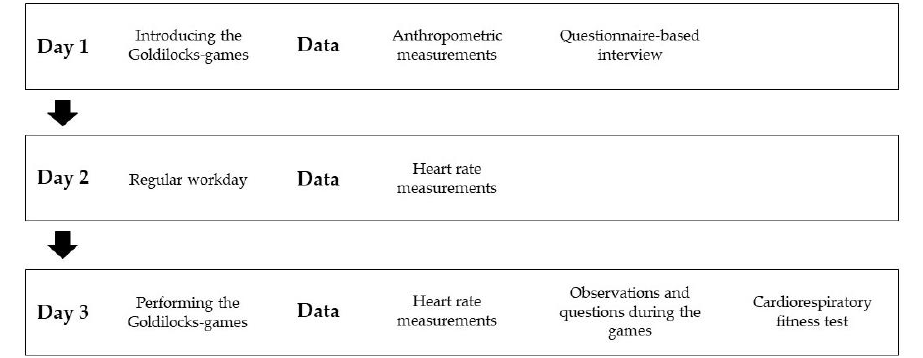
Figure 2. Study design for evaluating time with HIPA during a regular workday and the Goldilocks-games.